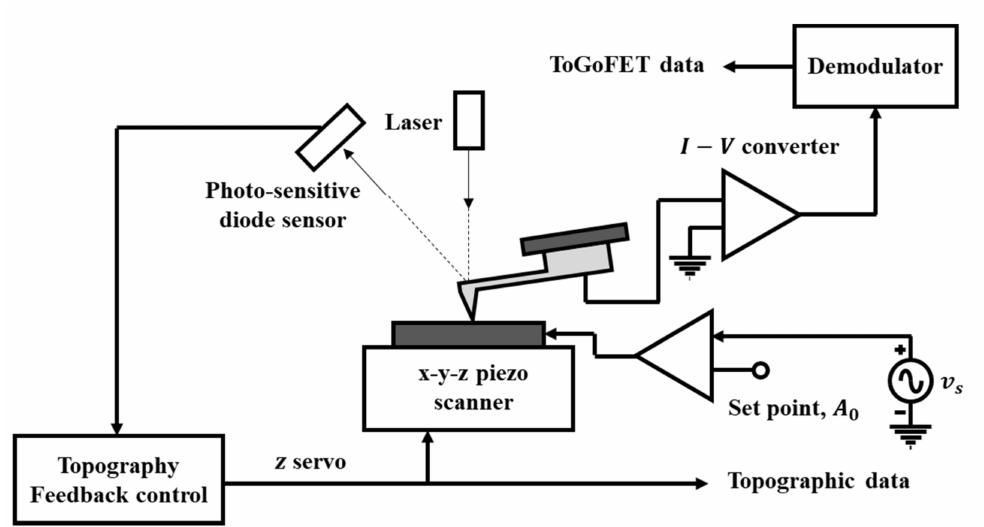
Figure 7. Schematic of the scanning probe microscopy (SPM) measurement set-up using the ToGoFET